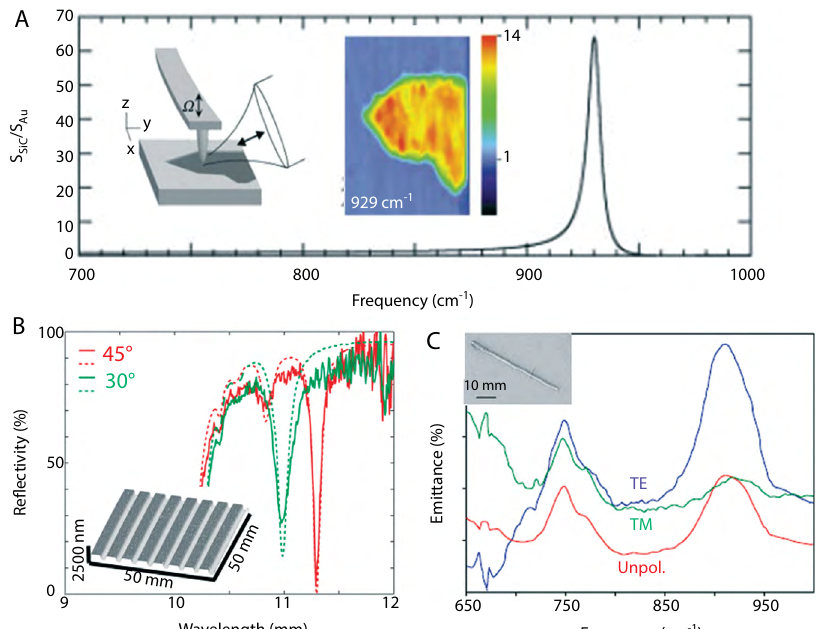
Figure 5 (A) Enhanced scattering spectrum of a SiC surface with respect to the surround gold surface within the mid-IR. Inset: schematic of the SNOM experimental setup and corresponding SNOM spatial plot. The Au and SiC surfaces exhibit low (blue) and high (yellow/red) scattering intensities within the plot. (B) Angle dependence of the reflectivity of SiC gratings within the Reststrahlen band demonstrating the ultranarrow and polarization sensitive SPhP response. Inset: AFM micrograph of SiC grating. (C) Polarized Mid-IR thermal emittance spectra of SiC whisker (inset). Reproduced with permission from Ref. [20] (A) [124], (B) and [51] (C).